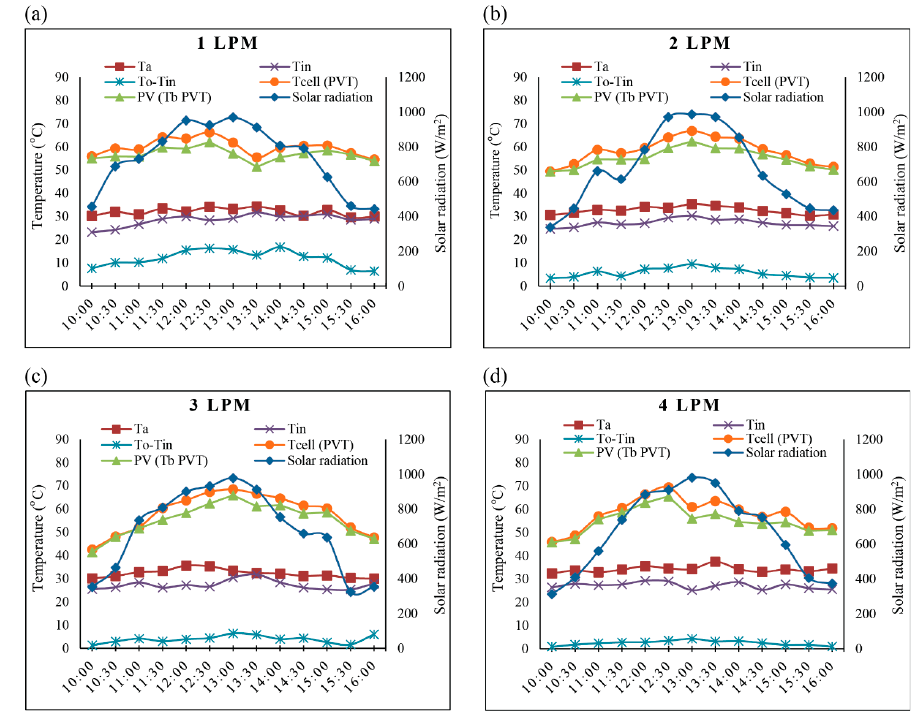
Figure 2. Daily variation of PVT parameters at ( a ) 1 LPM, ( b ) 2 LPM, ( c ) 3 LPM, and ( d ) 4 LPM mass flow rate.